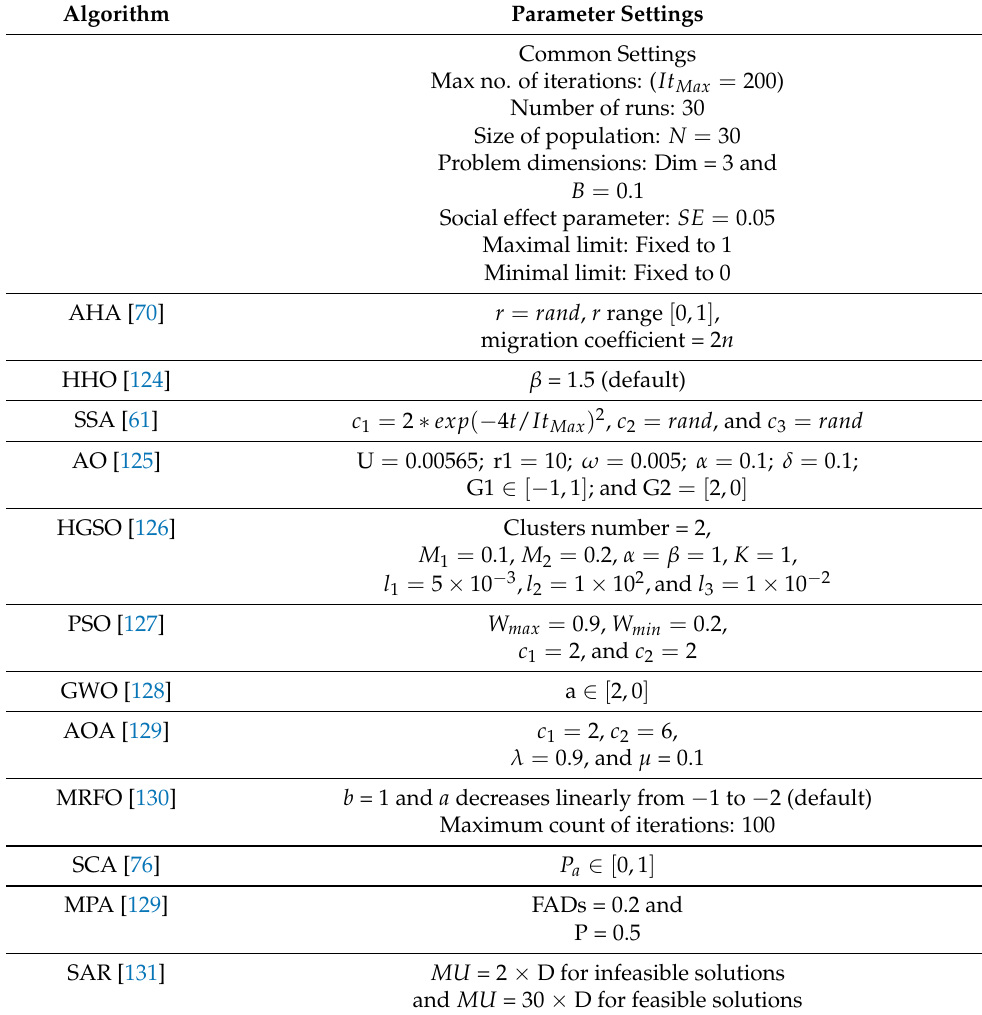
Table 1. Parameter settings of the AHA-ROBL and other computational